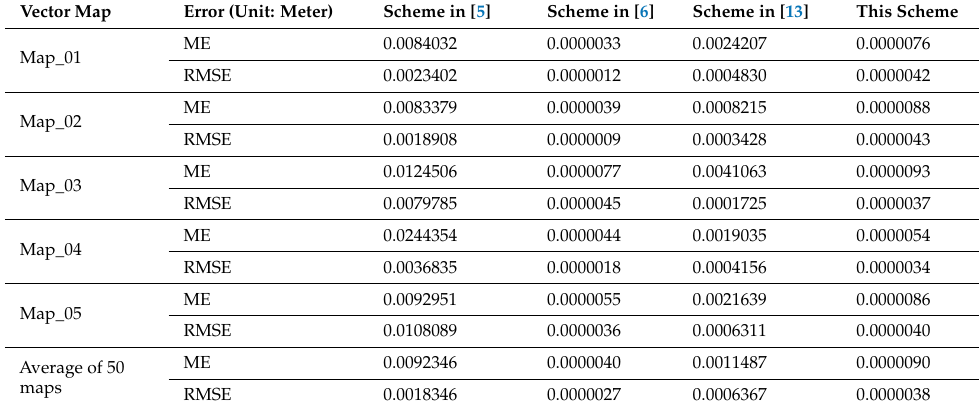
Table 8. The comparison results of invisibility among different watermarking schemes.